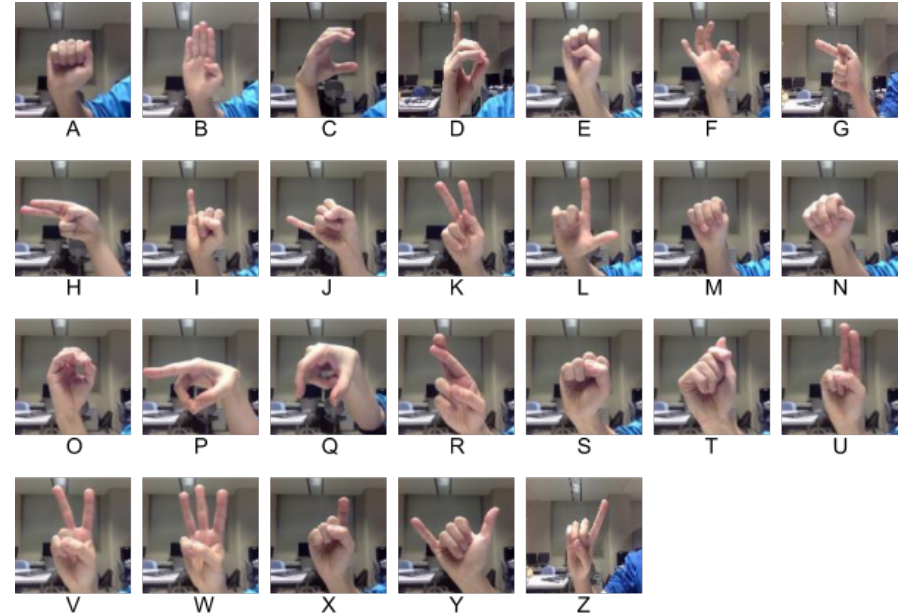
Figure 1. 26 characters of the American sign language alphabet.